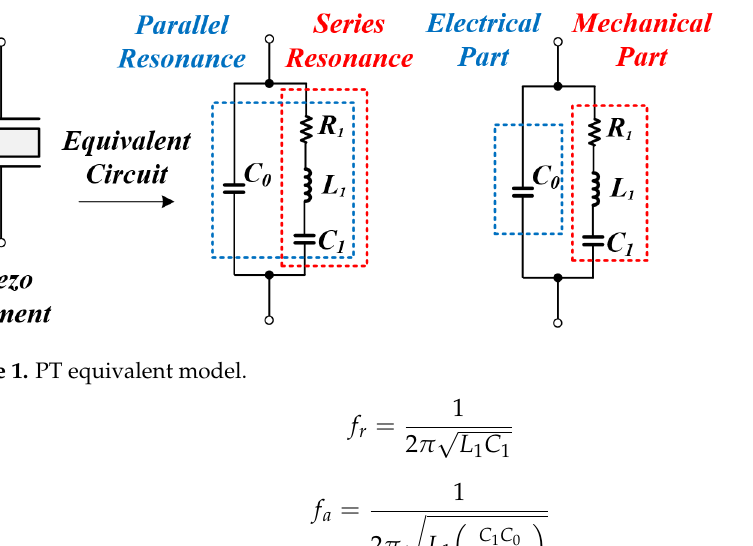
Figure 1. PT equivalent